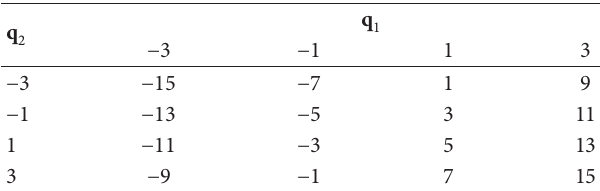
Table 1: The value of x